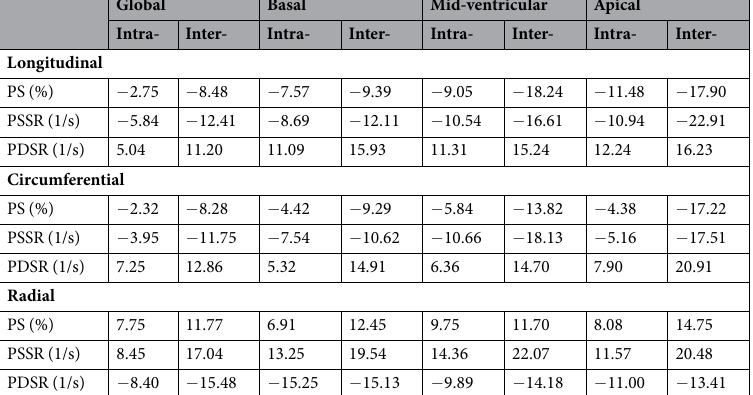
Table 2. Intra-observer and Inter-observer coefficient of variation of CMR Feature Tracking. Note: The coefficient of variation is given in %. PS = Peak Strain; PSSR = Peak Systolic Strain Rate; PDR = Peak Diastolic Strain Rate.